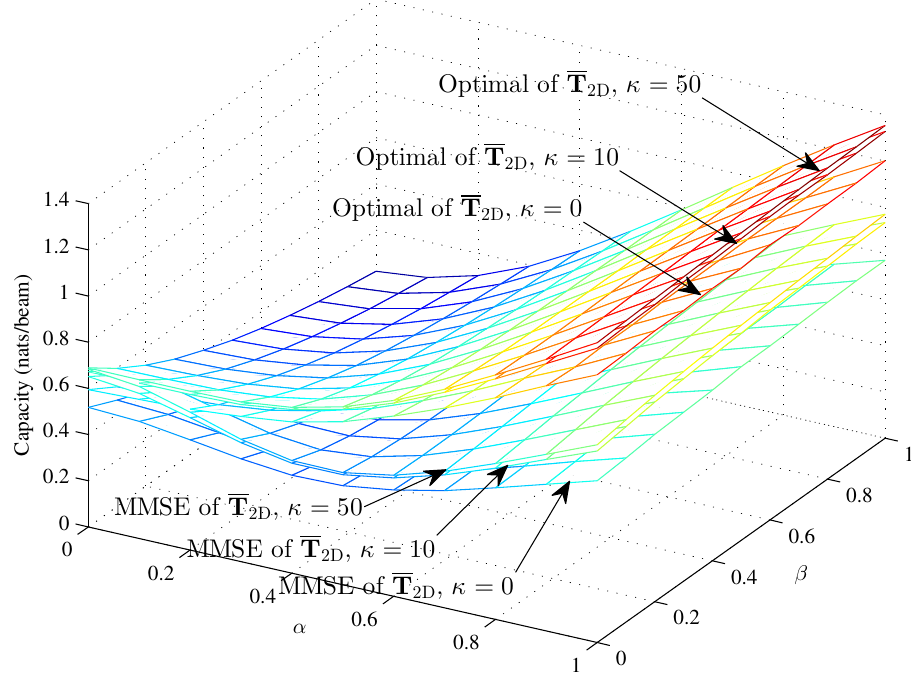
Figure 9. The optimal capacity and MMSE capacity of the hybrid 2D beams with γ = 1, L = 50 and M = 50 ( κ = 0, κ = 10 and κ = 50) versus α and β